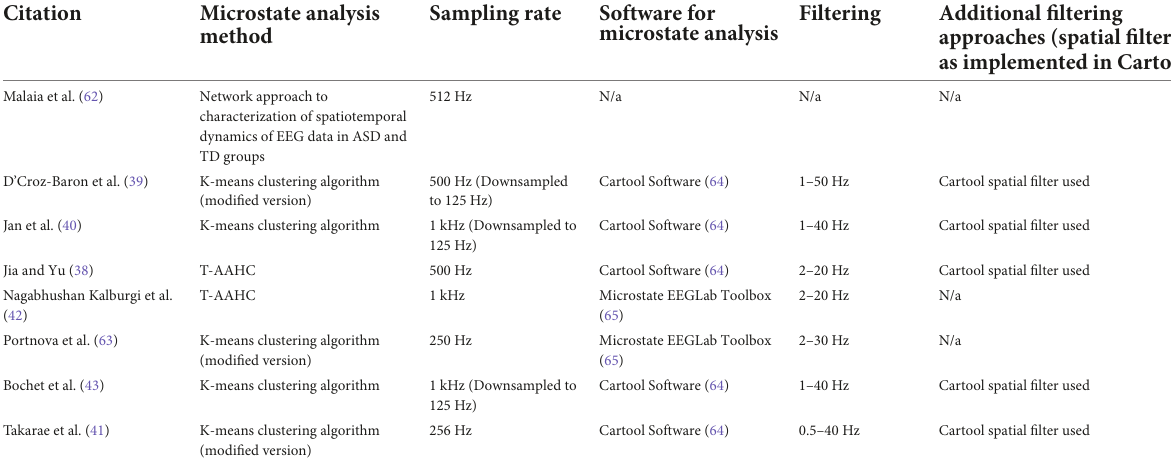
TABLE 3 Summary of methodology related to microstate analysis in ASD research.